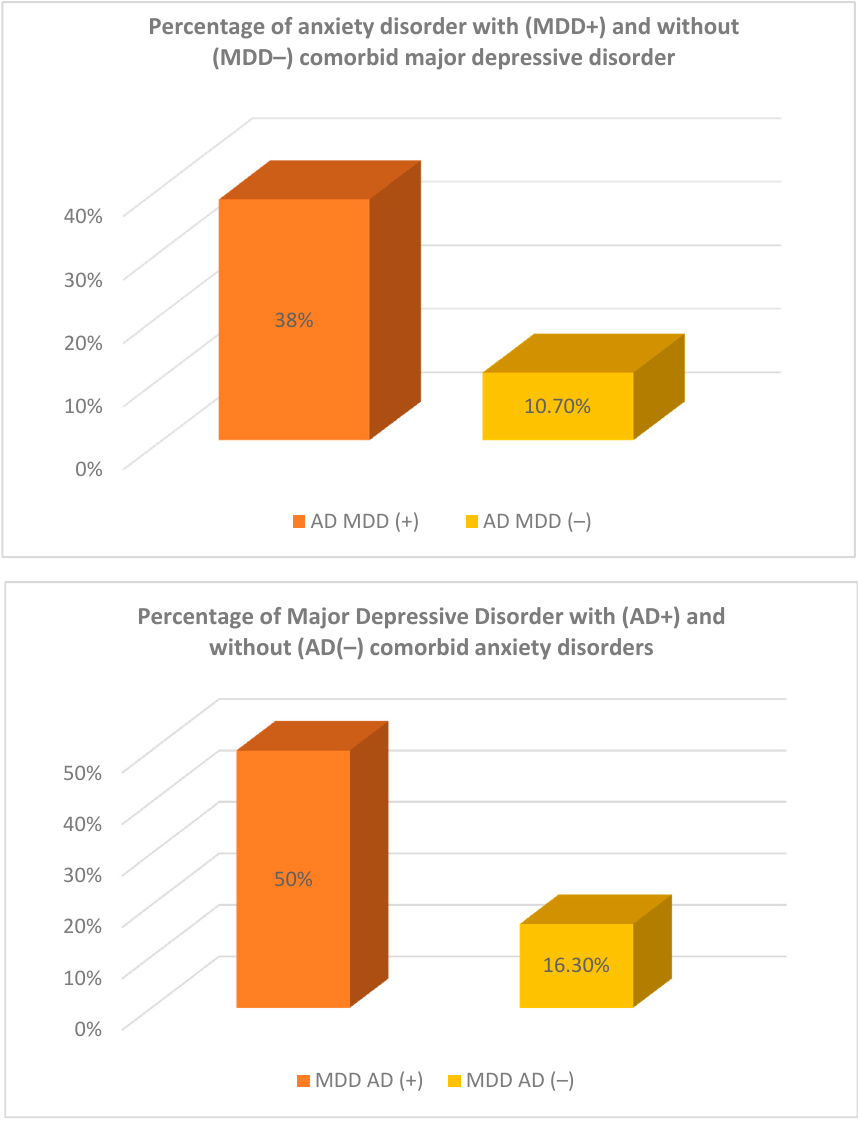
Figure 2. Percentage of patients with anxiety disorder/major depressive disorder with and without comorbid disorders. MDD = Major Depressive Disorder, AD = Anxiety Disorder, AD MDD(+) = Anxiety Disorder with comorbid Major Depressive Disorder, AD MDD( − ) = Anxiety Disorder without comorbid Major Depressive Disorder, MDD AD(+) = Major Depressive Disorder with comorbid anxiety disorders, MDD AD( − ) = Major Depressive Disorder without comorbid anxiety disorders.